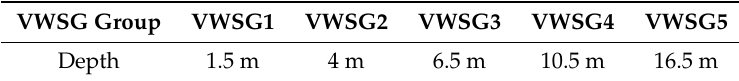
Table 1. Depth of VWSG groups in the borehole.